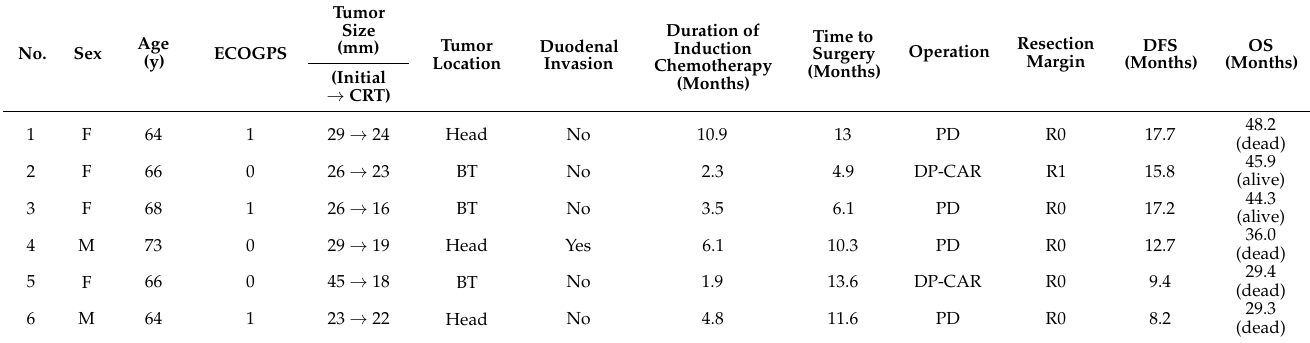
Table 3. Characteristics of patients who underwent conversion